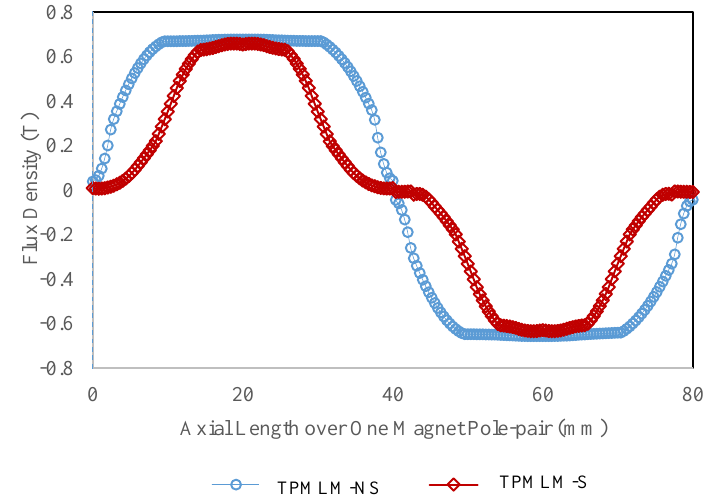
Figure 11. Airgap Flux Density along the Length of One Magnet Pole-pair.